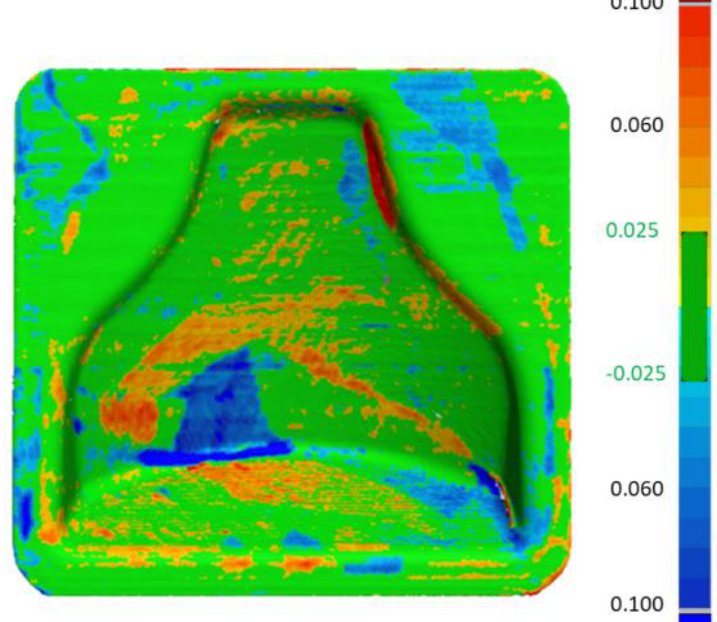
Figure 10. Comparison between the two molds after